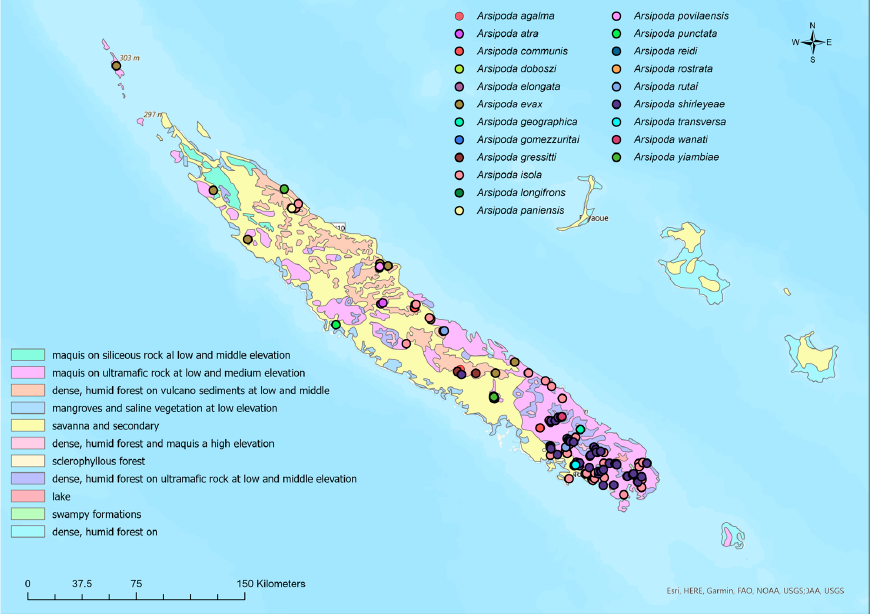
Figure 1. Occurrence localities for the 21 New Caledonian Arsipoda species and the vegetation types map redrawn by Jaffré et al. [43].